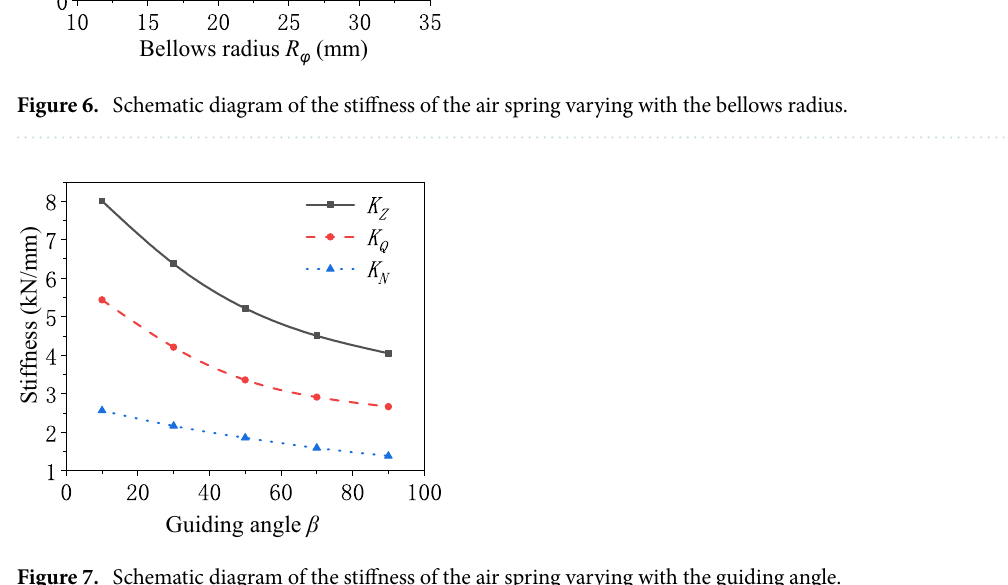
Figure 7. Schematic diagram of the stiffness of the air spring varying with the guiding